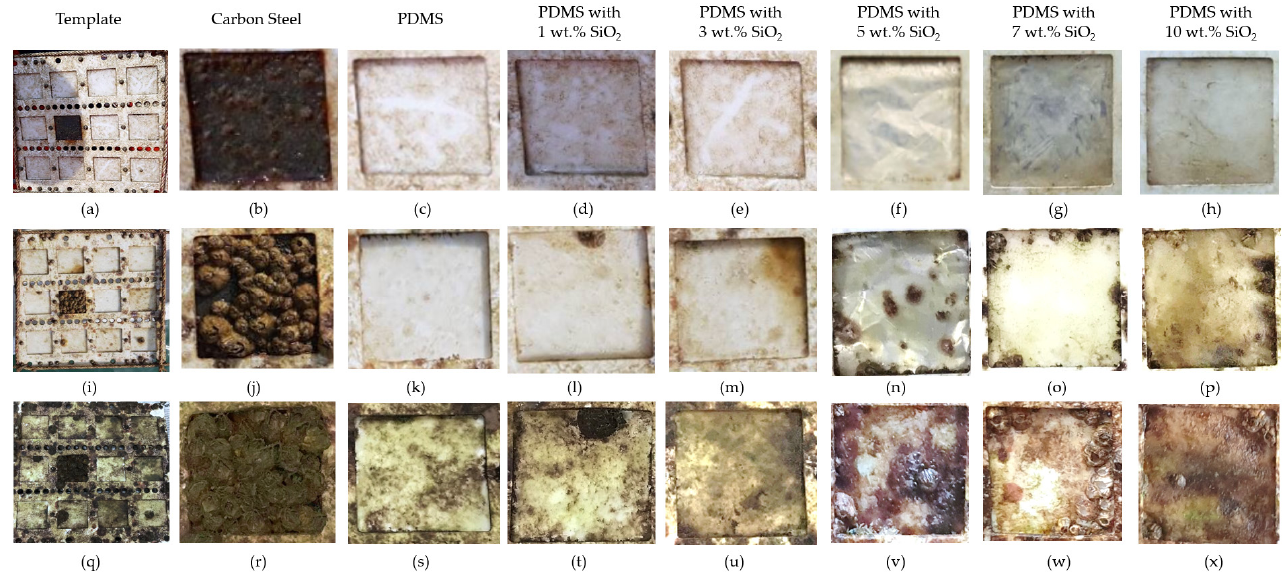
Figure 4. Marine biofouling on various sample surfaces after immersed in seawater environment (in April-June) ( a – h ) immersed for 2 weeks; ( i – p ) immersed for 4 weeks and ( q – x ) immersed for 8 weeks.